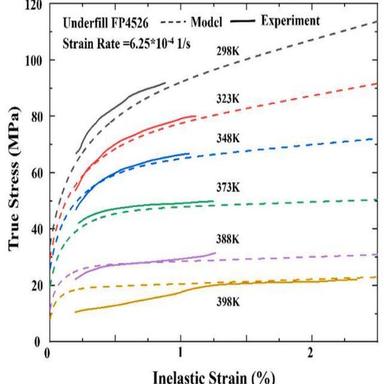
Comparison of the modified Qian-Liu model with the actual results for FP4526 underfill.